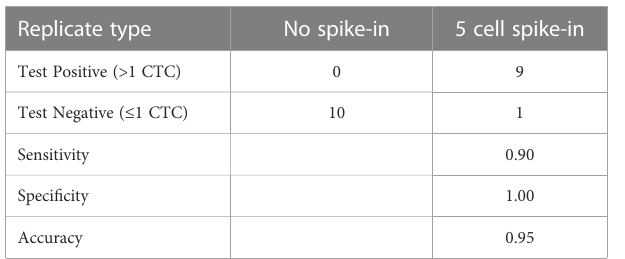
TABLE 2 Sensitivity, speci fi city and accuracy of detecting CTCs.